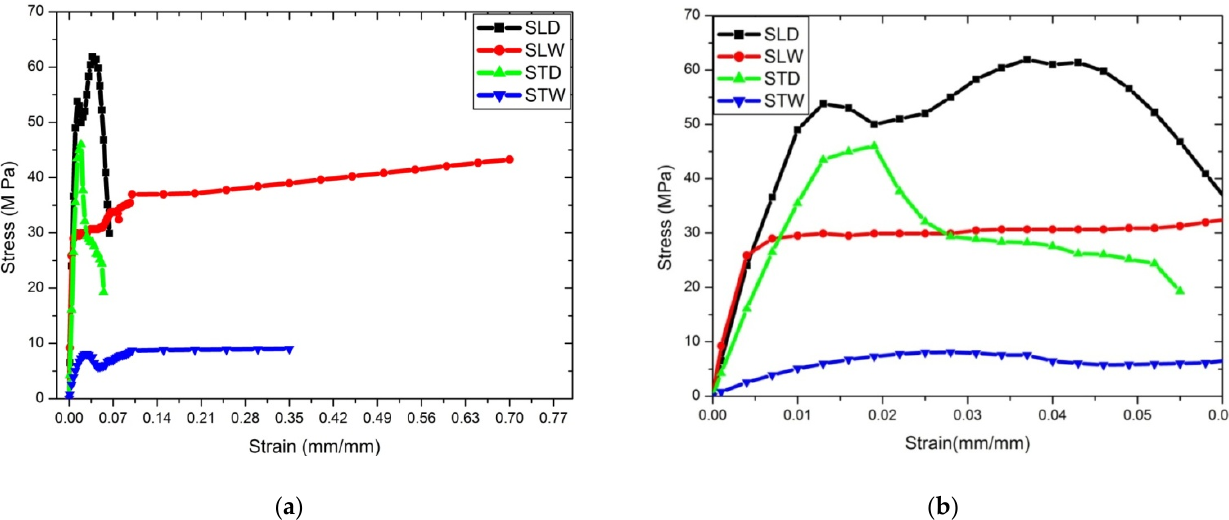
Figure 6. ( a ) Stress–strain curve for all samples and ( b ) stress–strain curve for closure image. Figure 6b represents the closure view of the stress–strain diagram. Figure 7a repre- sents the comparison of stress–strain diagram for the dry condition for both STD and SLD;